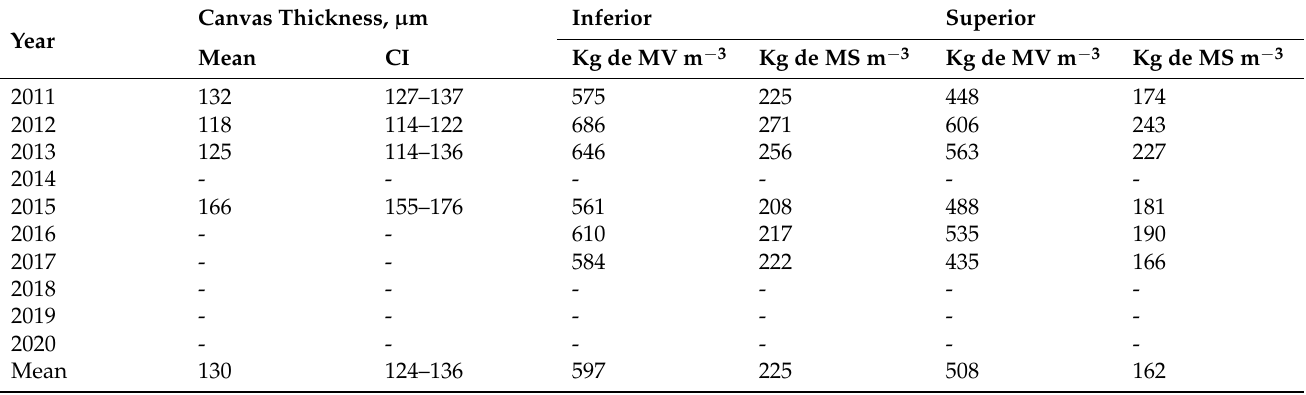
Table 10. Mean canvas thickness (CI–P >95%) and specific gravity of silage from silos sampled in the state of Paran á ,